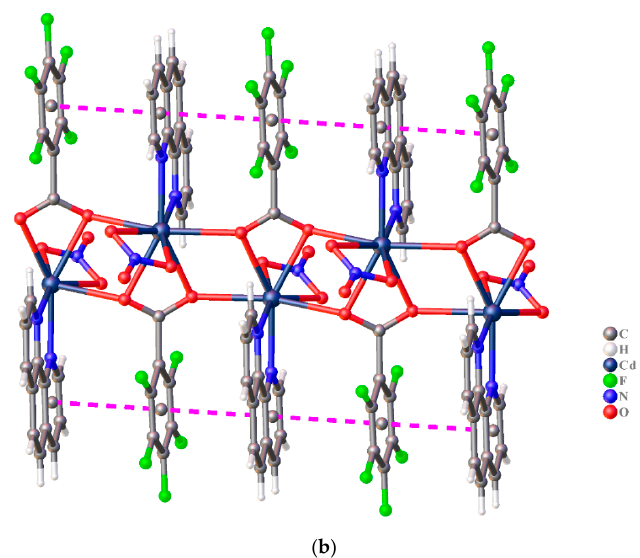
Figure 1. Structure of chains of polymer compounds 1 ( a ) and 2 ( b ) in crystals. The dotted line shows π ··· π interactions.